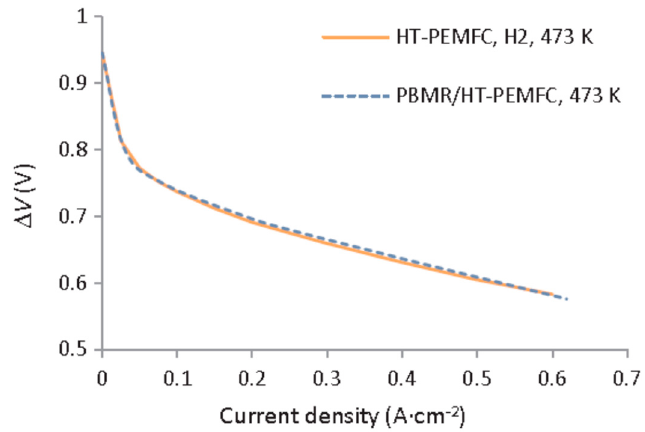
Figure 17. Simulations about the electric potential difference vs current density for a HT-PEMFC supplied by pure hydrogen and the integrated system combining a HT-PEMFC with a Pd-Ag MR operated at 200 °C. With permission of reprint of Elsevier from Ribeirinha et al. [63].